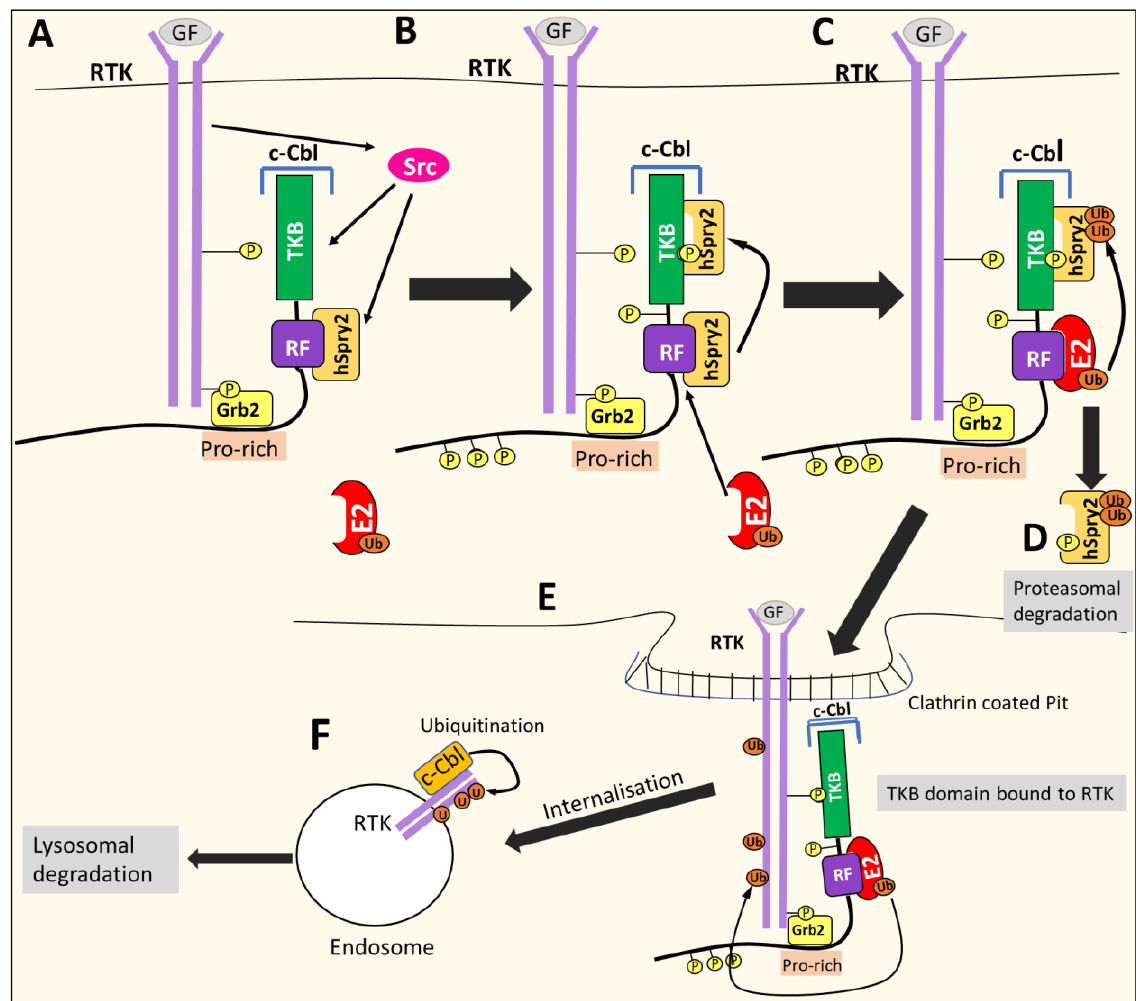
Figure 13. c-Cbl-mediated internalization, ubiquitination and degradation of activated RTKs. ( A ) Growth factor (GF) binding induces RTK auto-phosphorylation and recruits c-CBL to the activated receptor via the Grb2 adaptor protein. The RTK activates Src kinase, which phosphorylates c-Cbl and Sprouty2 (hSpry2), an inhibitor of c-Cbl’s E3 ligase activity. ( B ) Phosphorylated hSpry2 detaches from the ring finger domain (RF) and binds the terminal tyrosine kinase binding (TKB) domain of c-Cbl. ( C ) The RF domain of c-Cbl then recruits the E2-conjugating enzyme, which promotes the polyubiquitylation of hSpry2. ( D ) The polyubiquitylation of hSpry2 targets it for proteasomal degradation. ( E ) The TKB domain of c-Cbl is now free to bind the RTK, which enables c-Cbl to catalyze the addition of ubiquitin (Ub) molecules from E2 to the RTK. The addition of Ub leads to receptor internalization via endocytosis. ( F ) Ubiquitin molecules (Ub) continue to be added, and mark the RTK for lysosomal degradation.